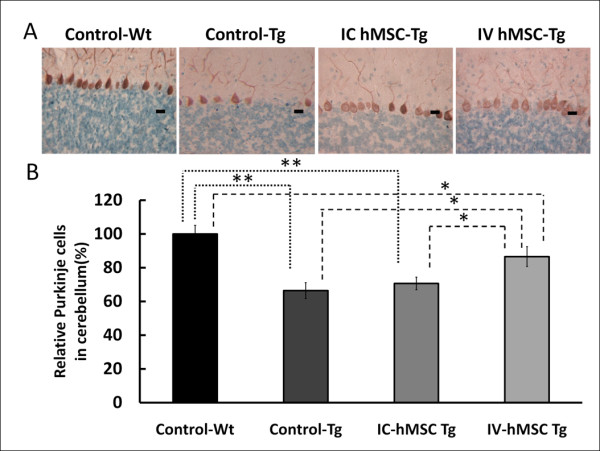
Immunohistochemistry staining for murine Purkinje cells in cerebellum. (A) Whole brain sections of wild-type mouse, SCA2 Tg mouse as control, and SCA2 transgenic mouse which received intravenous and intracranial human mesenchymal stem cells transplantation (4 μm) were processed by immunohistochemistry of calbindin D28K for Purkinje cells. Photographs were taken from the view of 100-folds microscopy and the scale bar was 40 μm. (B) Quantitative counting of calbindin D28K+ cells in cerebellum were compared to those of Control-Wt. Statistical analysis was performed by one-way ANOVA. (* p < 0.05; ** p < 0.001).